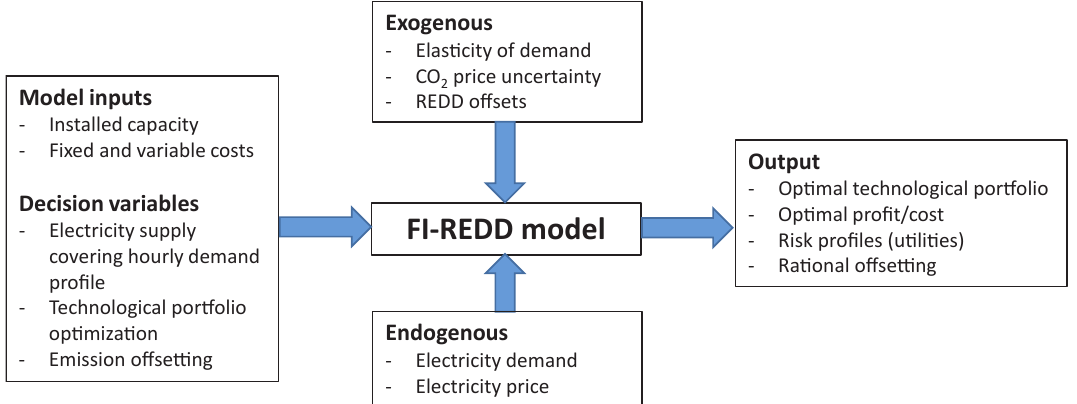
Figure 1. Scheme of the FI-REDD